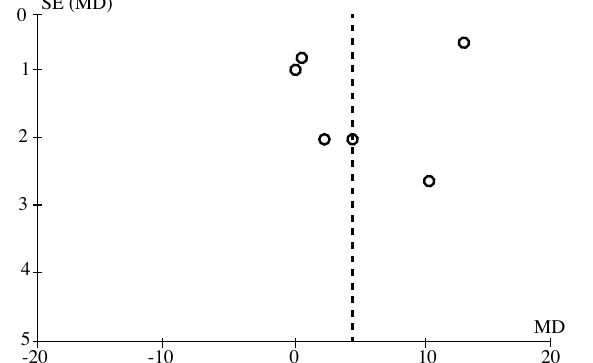
Figure 8. Funnel plot of the seven results of the five studies selected for the posterior muscle chain extensibility measured through the “Sit and Reach” (cm) test from the Rikli Jones test battery. The Egger Test was performed with bias = 10.164386 (95% CI = 2.635451 to 17.693321) and P = 0.0178.